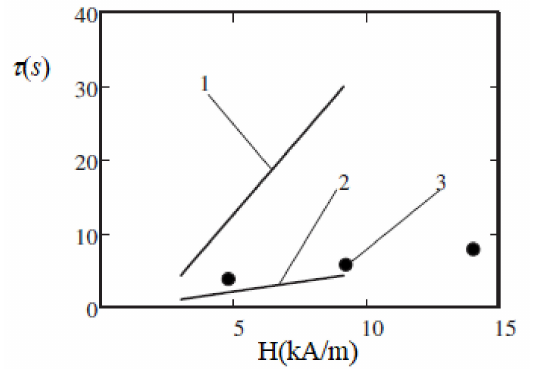
Figure 10. Relaxation time τ versus the applied magnetic field H . Curves 1 and 2—theoretical calculations [92] for a ferrofluid with the same parameters as in Figure 9. Theory: the shear rate changed in a stepwise manner from 16 s − 1 to 1.6 s − 1 (line 1) and back (line 2). Dots 3—experiments [70] with an oscillating shear flow. Published with the permission of the American Physical Society (license RNP / 20 / AUG /